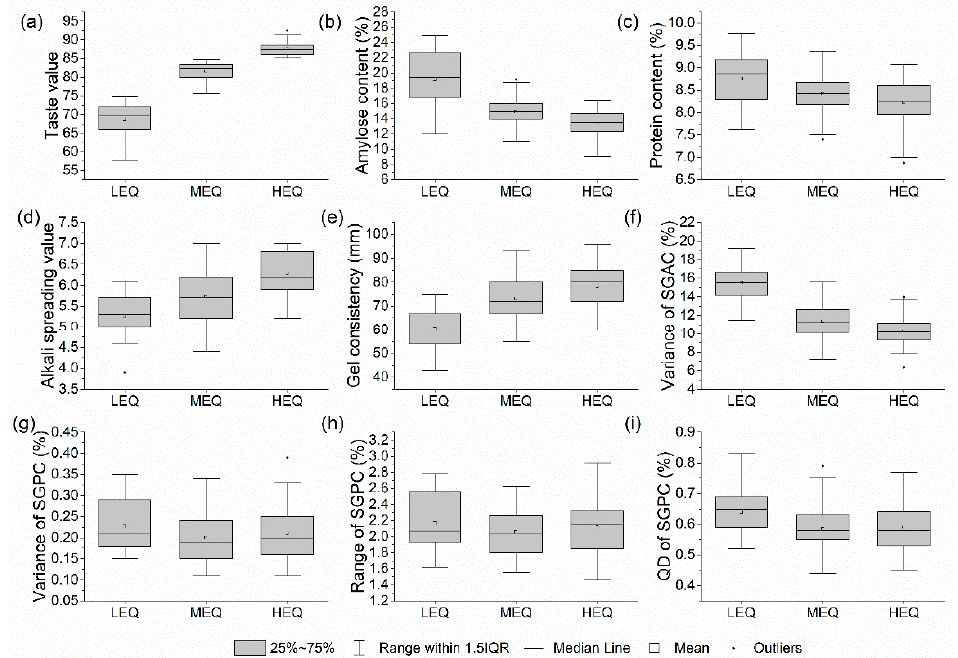
Figure 6. The box plots of taste value ( a ), physicochemical indicators ( b – e ), dispersion indices of SGAC and SGPC ( f – i ) for low eating quality (LEQ, taste value ≤ 75), medium eating quality (MEQ, 75 < taste value ≤ 85), and high-eating-quality (HEQ, taste value > 85) hybrid indica rice.